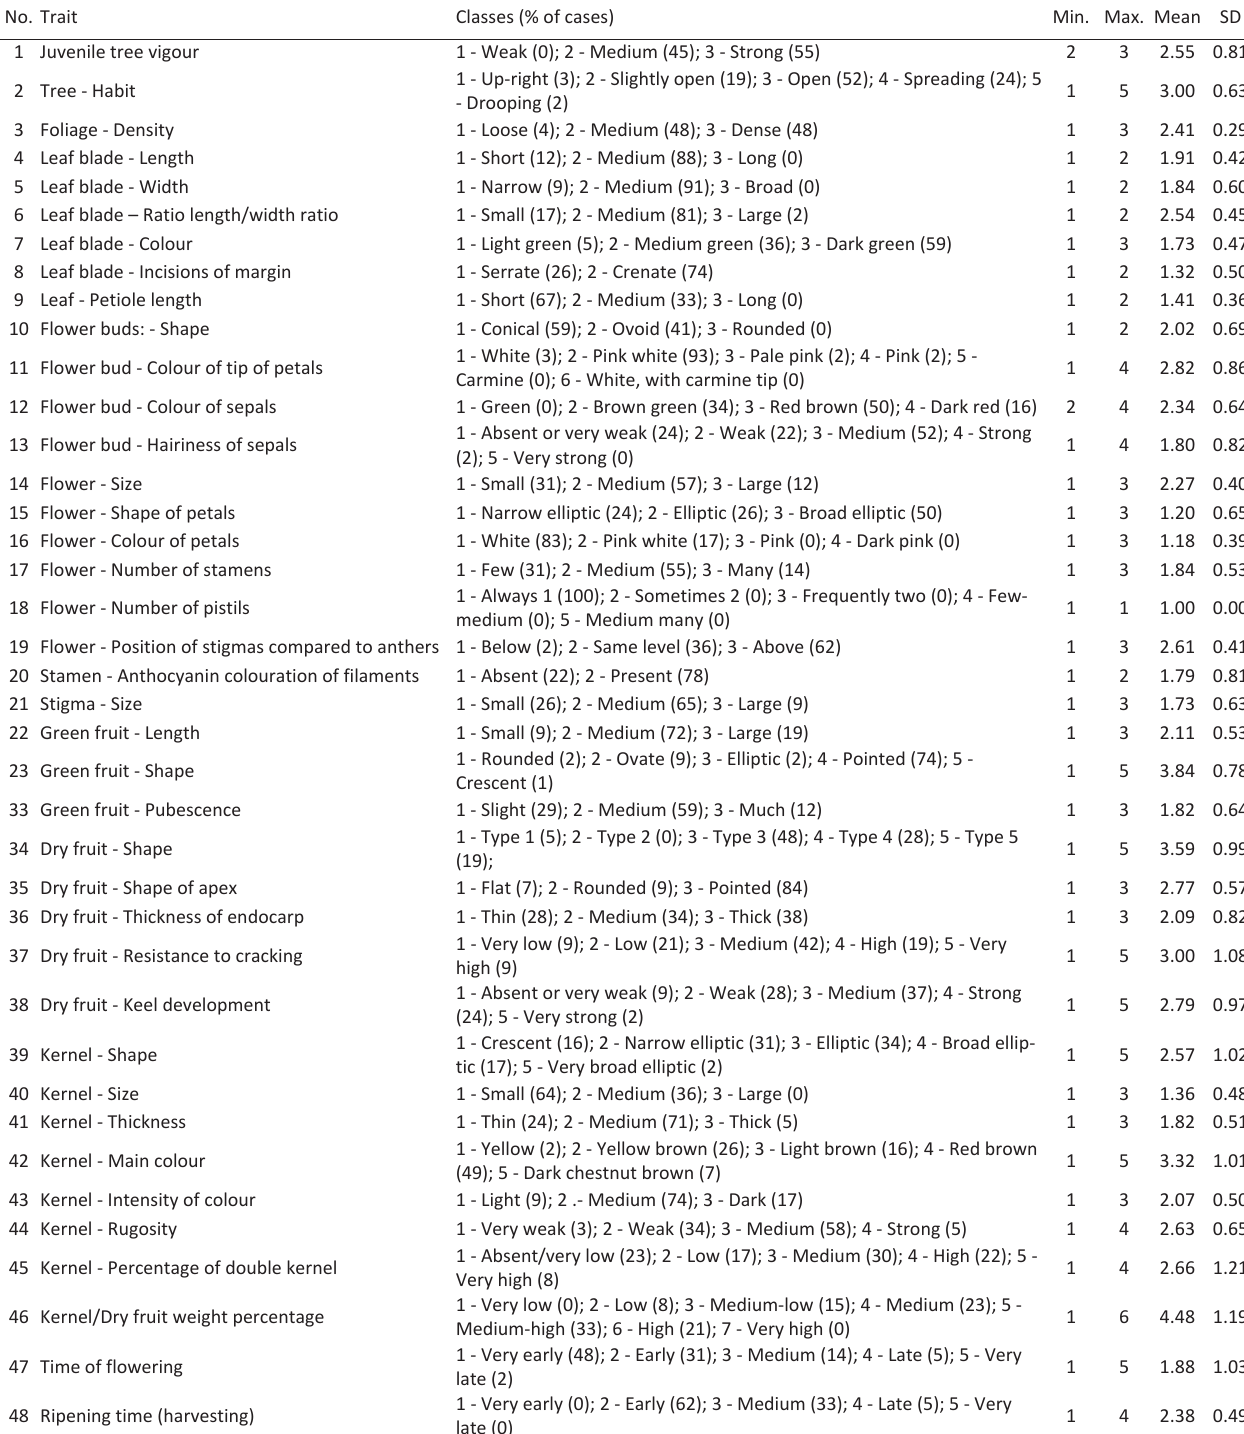
Table 2 - List of phenotypic traits, codes, states, classes and descriptive statistics adopted to describe the set of 56 accessions from the National Collection of Almond from Afghanistan. In brackets the percentage of cases observed for each note/descriptor No. Trait Classes (% of cases) Min. Max. Mean